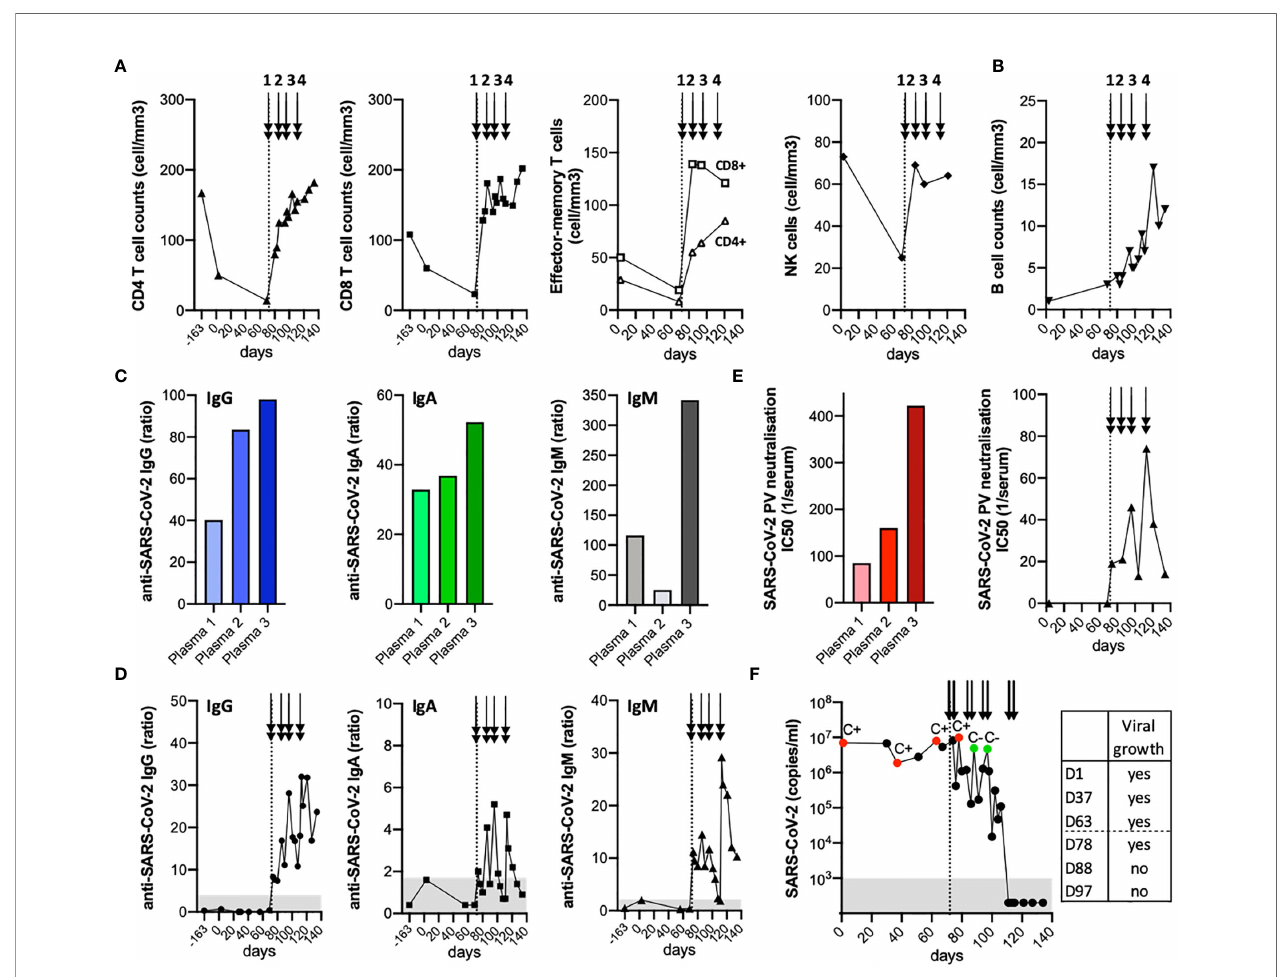
FIGURE 2 | Anti-SARS-CoV-2 antibody and SARS-CoV-2 mRNA follow-up before and after plasma transfusions. (A, B) , Timeline showing absolute CD4 and CD8 T cell counts, including effector-memory subsets and NK cell counts (A) , and absolute B cell counts (B) . (C, D) , Anti-SARS-CoV-2 S protein IgG, IgA and IgM antibody levels as assessed by an in-house developed Luminex assay for each plasma (C) as well as in the patient ’ s serum before and following plasma transfusions (D) . (E) , Activity of neutralizing antibodies was assessed by a SARS-CoV-2 pseudovirus neutralization assay for each plasma and in patient ’ s serum at different time- points. (F) , Over-time follow-up of SARS-CoV-2 RNA detection in nasopharyngeal swabs. The cytopathic effect on VeroE6 cells was evaluated after inoculation with SARS-CoV-2 from nasopharyngeal swabs: C+, successful virus isolation; C-, absence of virus isolation. (A – F) , The arrows indicate the 4 cycles of plasma transfusion (two units given on two consecutive days of each ( Figure 2D and Supplementary Figure 3B ). A similar trend, albeit at much lower levels, was found for anti-S IgA antibodies.